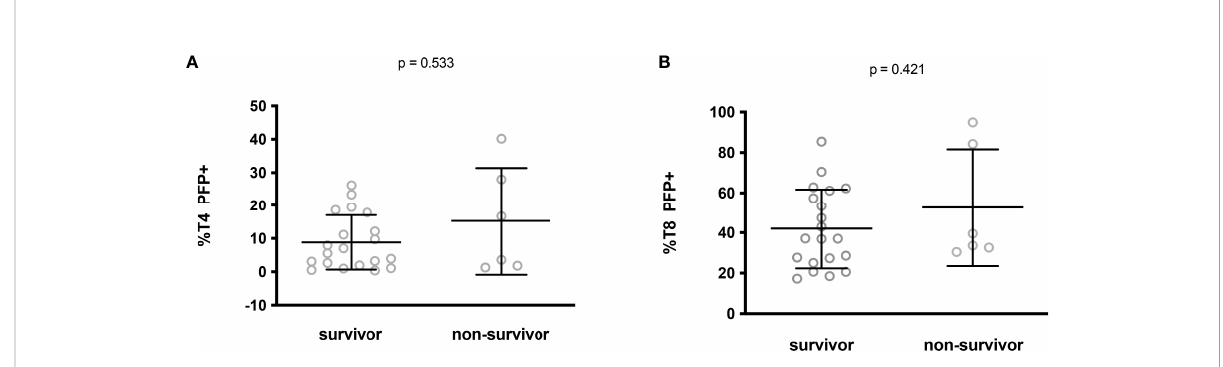
FIGURE 4 Perforin expression in CD4+ (A) and CD8+ (B) lymphocytes from ICU patients who survived or not.